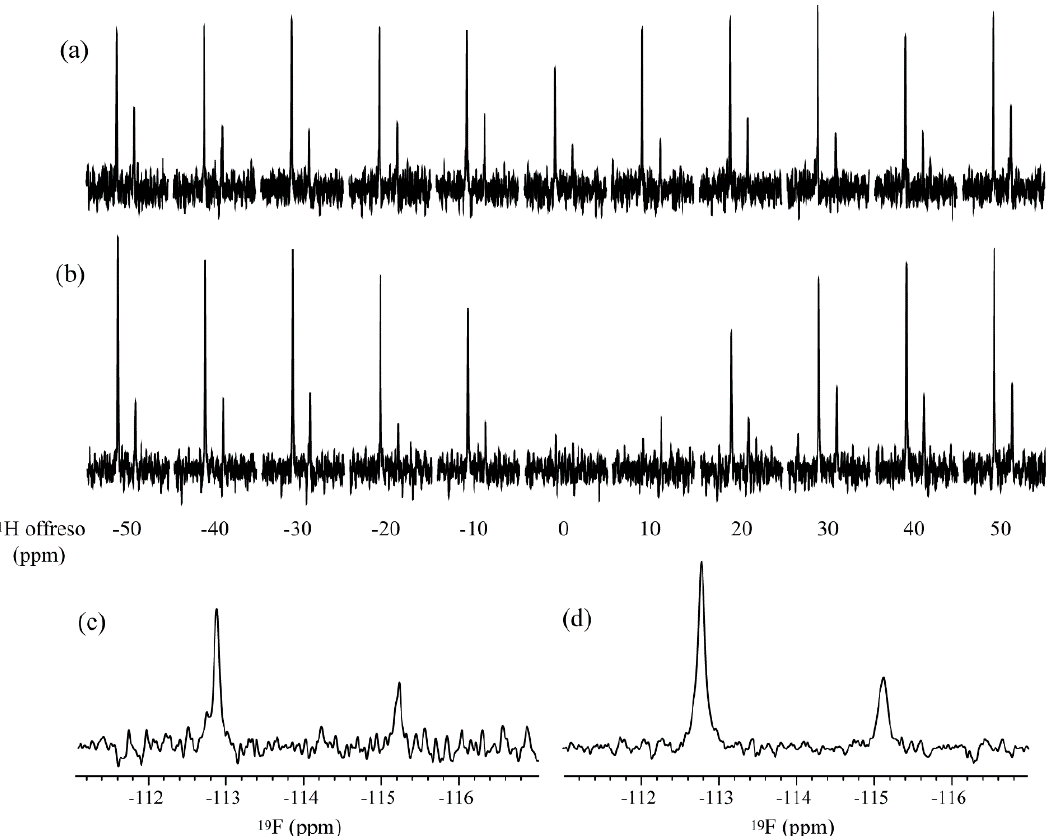
Figure 4. The 19 F{ 1 H} STD spectra acquired using ( a ) a rectangular pulse and ( b ) Gaussian shaped pulses for 1 H saturation. The 1 H on-resonance frequency was set to 0.6 ppm, and the 1 H off-resonance frequencies were arrayed in the range of −50 to 50 ppm. The expanded spectra acquired using ( c ) a rectangular and ( d ) Gaussian shaped pulses. The 1 H off-resonance frequencies were ( c ) −20 ppm and ( d ) −30 ppm.